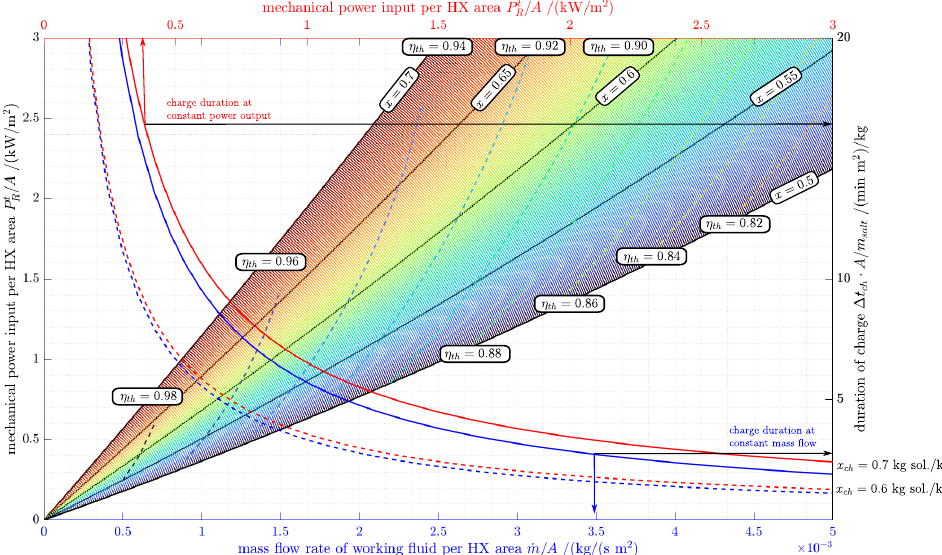
Figure 14. Operation map of the charging process for the parameters reflected in Table